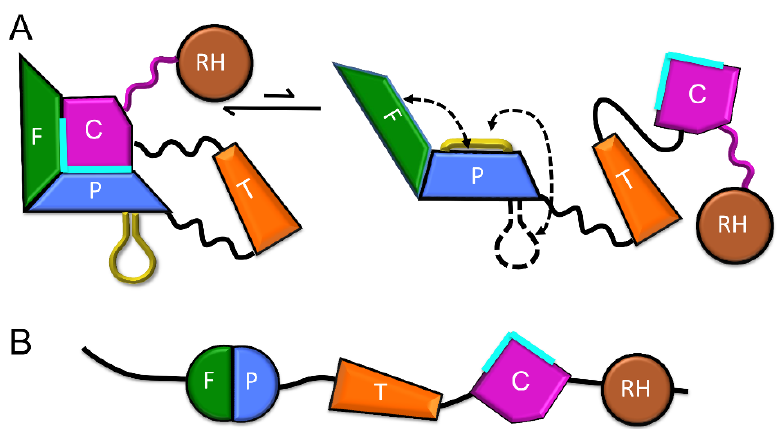
Figure 4. Schematic representation of fingers/palm:connection dissociation in p66 M . ( A ) The structure of p66 M approximates a domains-on-a-string model in which a few of the domains—corresponding to the fingers/palm:connection cluster—remain associated. Subsequent to dissociation, the non-dissociable fingers/palm domains adopt an altered, more extended conformation, in which the initially disordered palm loop (gold) is recruited to the inner surface of the palm domain. These conformational changes reduce the tendency toward reassociation, introducing kinetic barriers that extend the lifetime of the fully dissociated species. Dissociation exposes the hydrophobic surface of the connection (C) domain (cyan); ( B ) Beads-on-a-string model of the fully domain-dissociated monomer, in which the hydrophobic surface of the C domain (cyan) provides the initial interaction surface for dimer formation with a second, non-dissociated p66 M molecule. Domain color coding as in Figure 2.